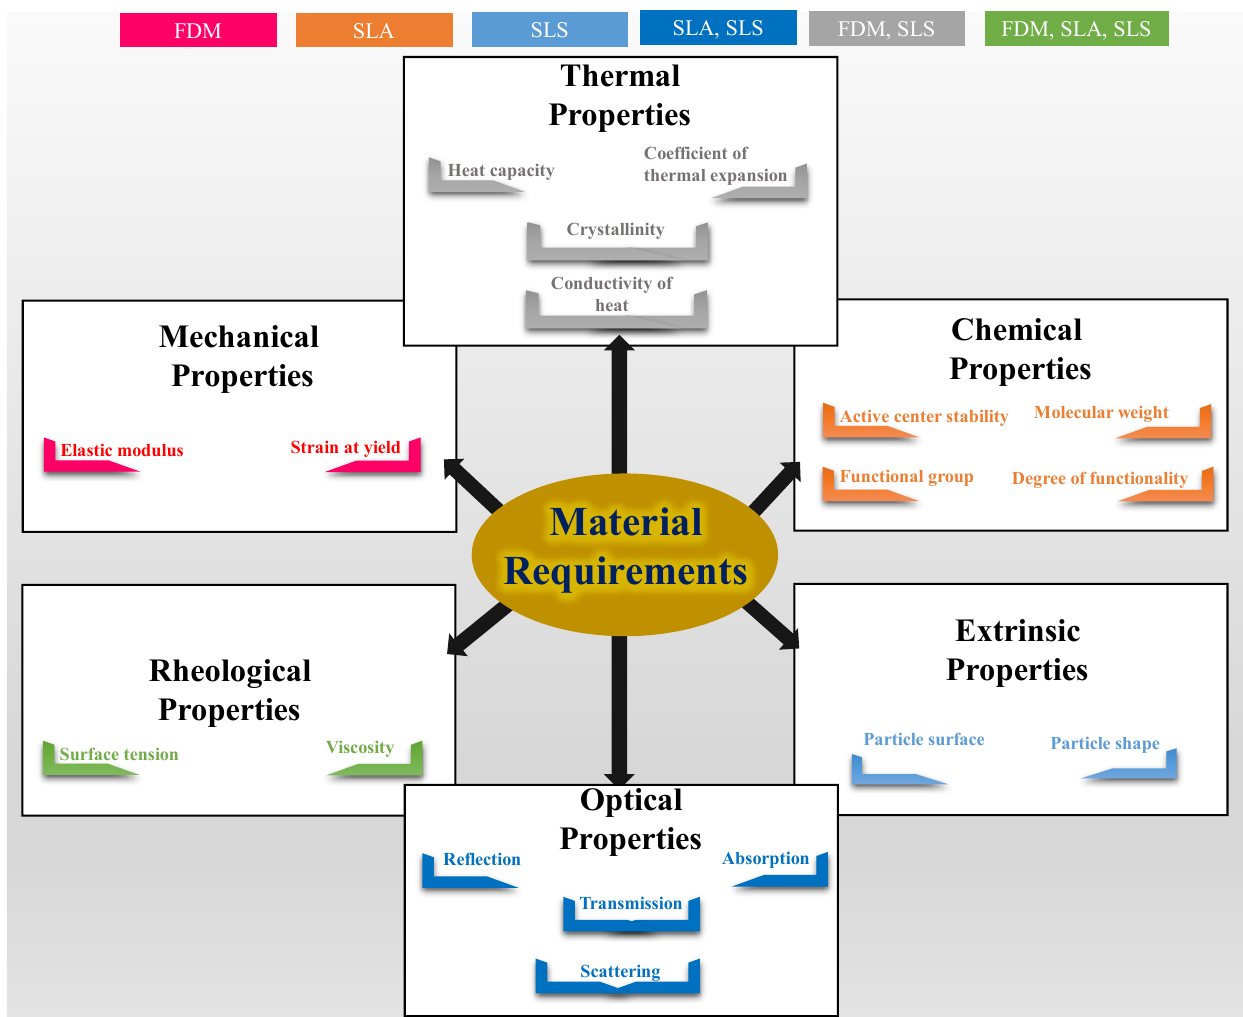
Figure 5. A pictographic summary of the various properties of print materials demanded for successful printability via FDM, SLS, and SLA 3D printing.